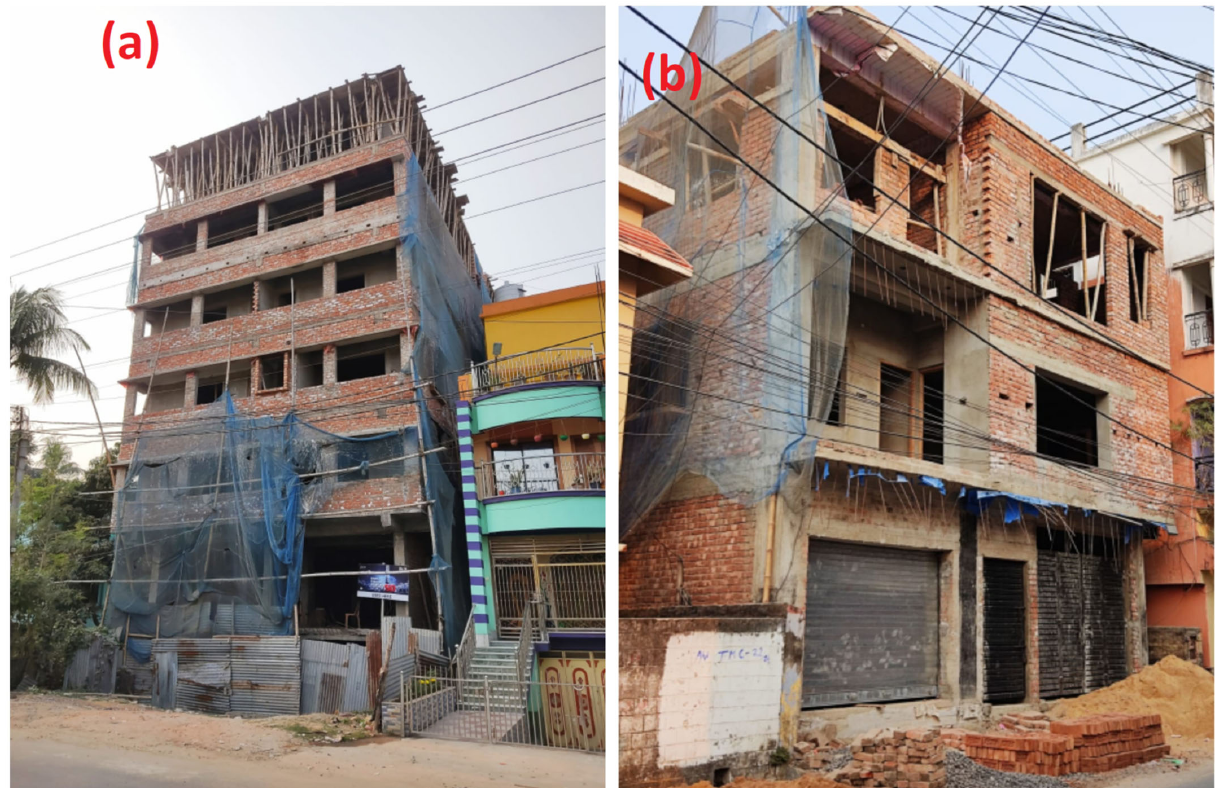
Figure 9. Fuzzy logic-based ( A ) built-up stability model, and ( B ) built-up expansion probability model for English Bazar.